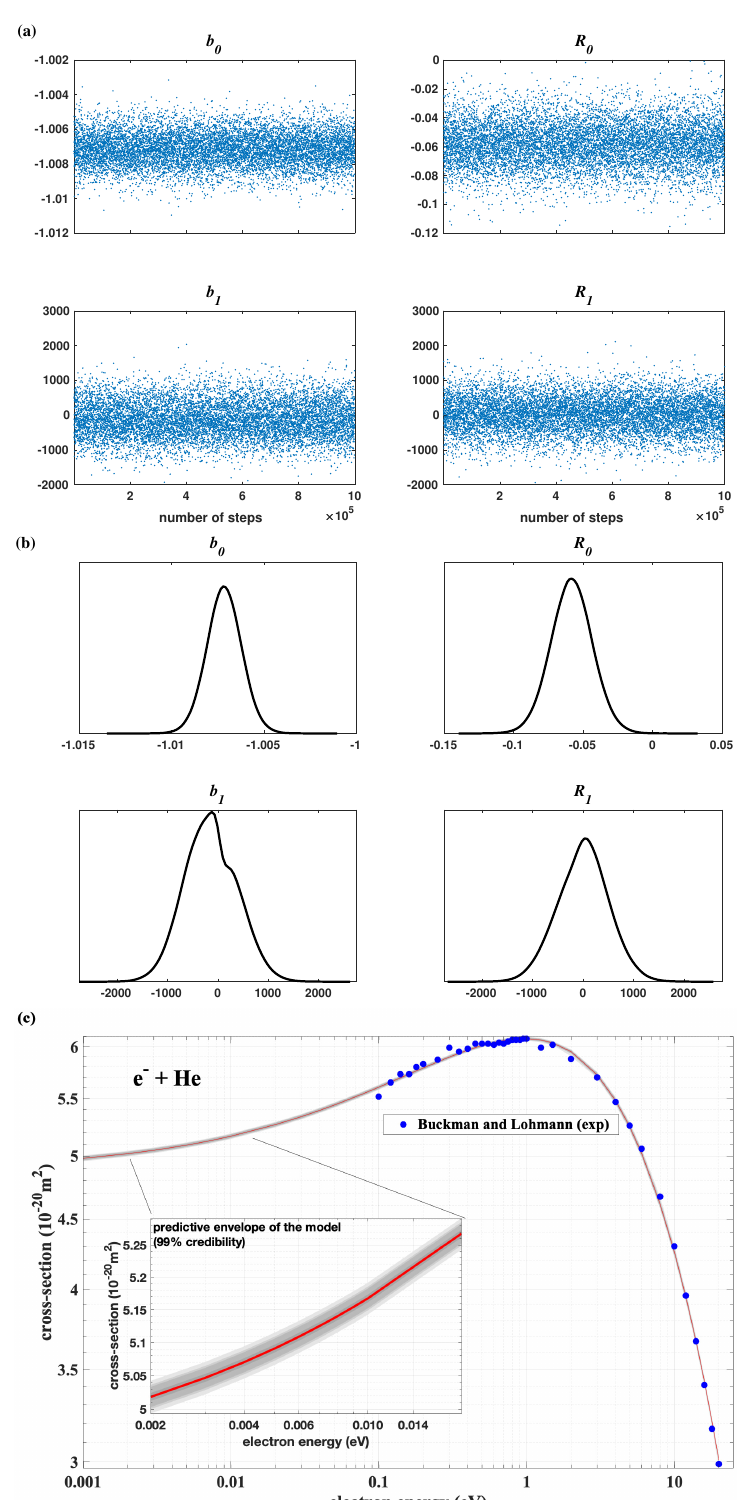
Figure 1. MCMC − MERT fit to experimental total cross − sections for electron − helium scattering by Buckman and Lohmann [34]: ( a ) Markov Chains for MERT parameters ( b 0 , R 0 , b 1 , R 1 ) determined during the fitting procedure. ( b ) Posterior probability density functions (PDFs) for MERT parameters estimated from Markov Chains. ( c ) MERT calculations using mean values of PDFs (solid line) and a 99% credible region (darkened gray